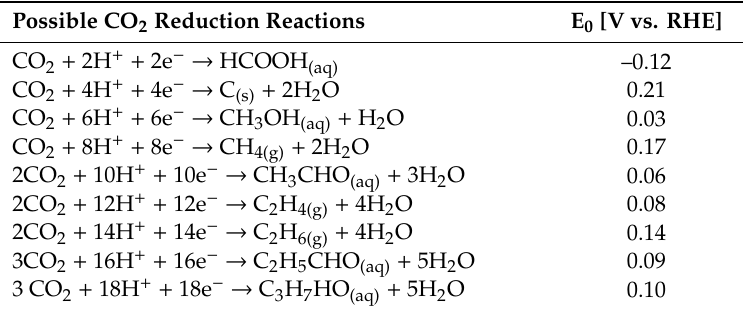
Table 1. Selected pathways of CO 2 reduction with equilibrium